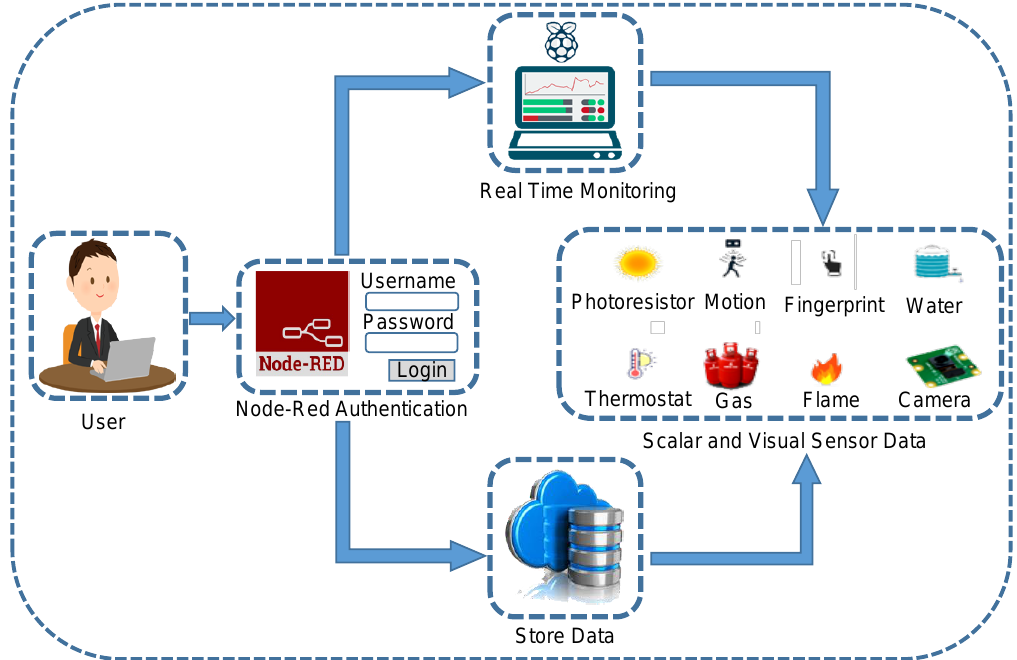
Figure 4. Application layer workflow, where users can sign in through their username and password for real-time data-monitoring of different sensors.